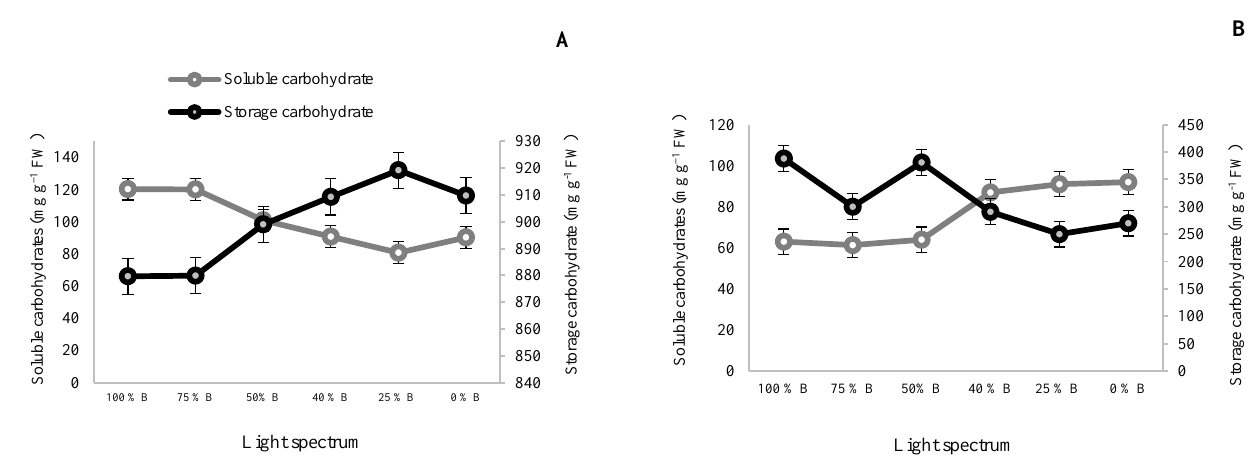
Figure 3. Concentration of soluble and storage carbohydrates in the leaves ( A ) and corms ( B ) of saffron plants grown under different ratios of blue (B) to Red (R) light in the overall spectral composition, including 100% B, 75% B, 50% B, 40% B, 25% B, 0% B (see the spectrum in Figure 1), with 150 ± 10 µ mol m − 2 s − 1 PPFD. Bars represent mean value ± standard deviation ( p ≤ 0.01).